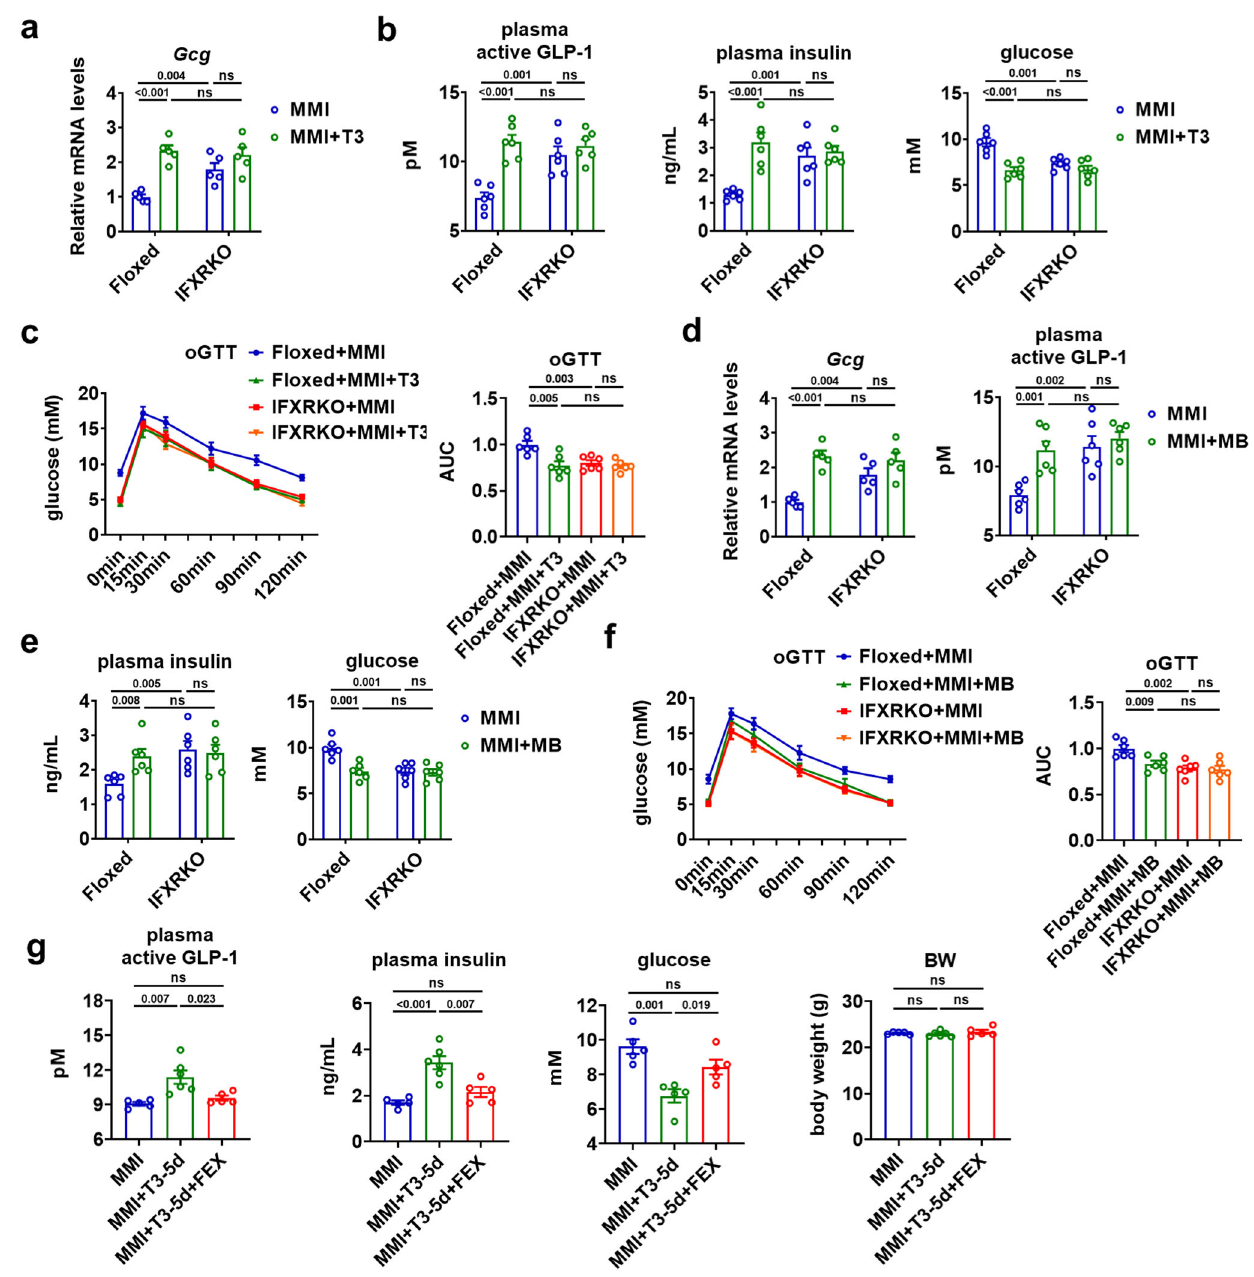
Fig. 7 | Intestinal FXR mediates the hepatic T3 effect on the GLP-1 production andglucosehomeostasis.a RelativemRNAlevelsof Gcg intheileumofFloxedand IFXRKOmicetreatedwithMMIorbothMMIand5daysofT3( n =5). b Plasmaactive GLP-1,plasmainsulin, and bloodglucose levelsinFloxed and IFXRKO micetreated withMMIorbothMMIand5daysofT3( n =6). c oGTTforFloxedandIFXRKOmice treatedwithMMIorMMIand5daysofT3(left)andtheAUCforoGTT(right)( n =6). d RelativemRNAlevelsof Gcg intheileumandplasmaactiveGLP-1levelsofFloxed and IFXRKO mice treated with MMI or MMI and 5 days of MB ( n =5). e Plasma